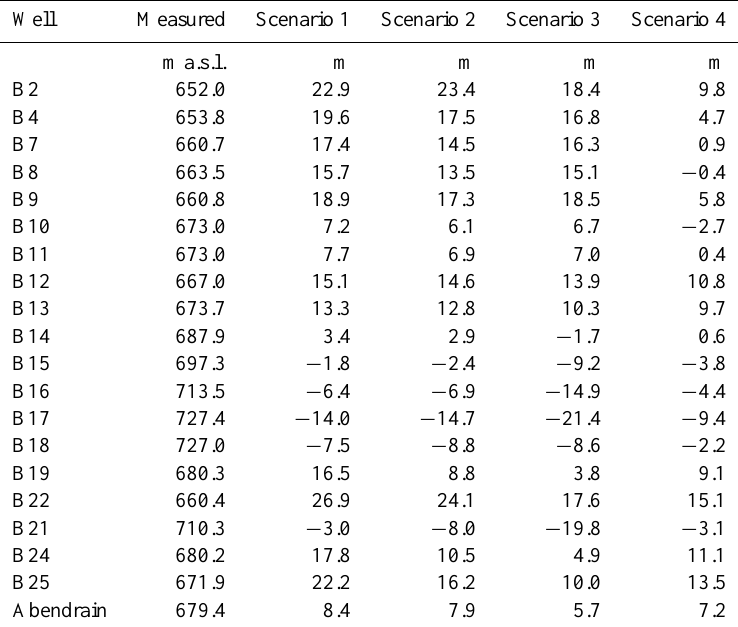
Table 3. Measured hydraulic head values that were used for calibration. For each scenario the difference of the simulated to the measured hydraulic heads is given in meters. The positions of the observation wells are given in Fig.